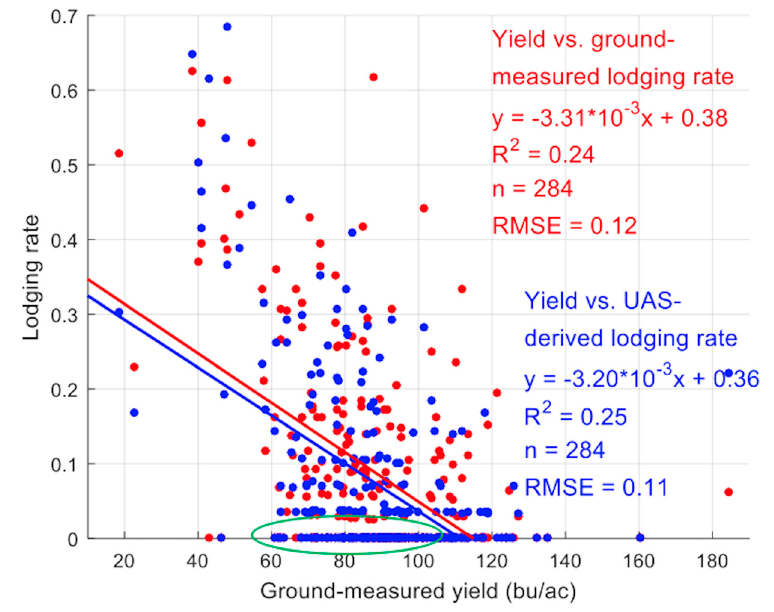
Figure 14. Yield in response to the UAS-estimated and ground-measured lodging rate. Red and blue solid lines indicate their corresponding linear regressions. Green oval shows low yielding plots due to low germination and stand counts, poor genetic suitability, or both.